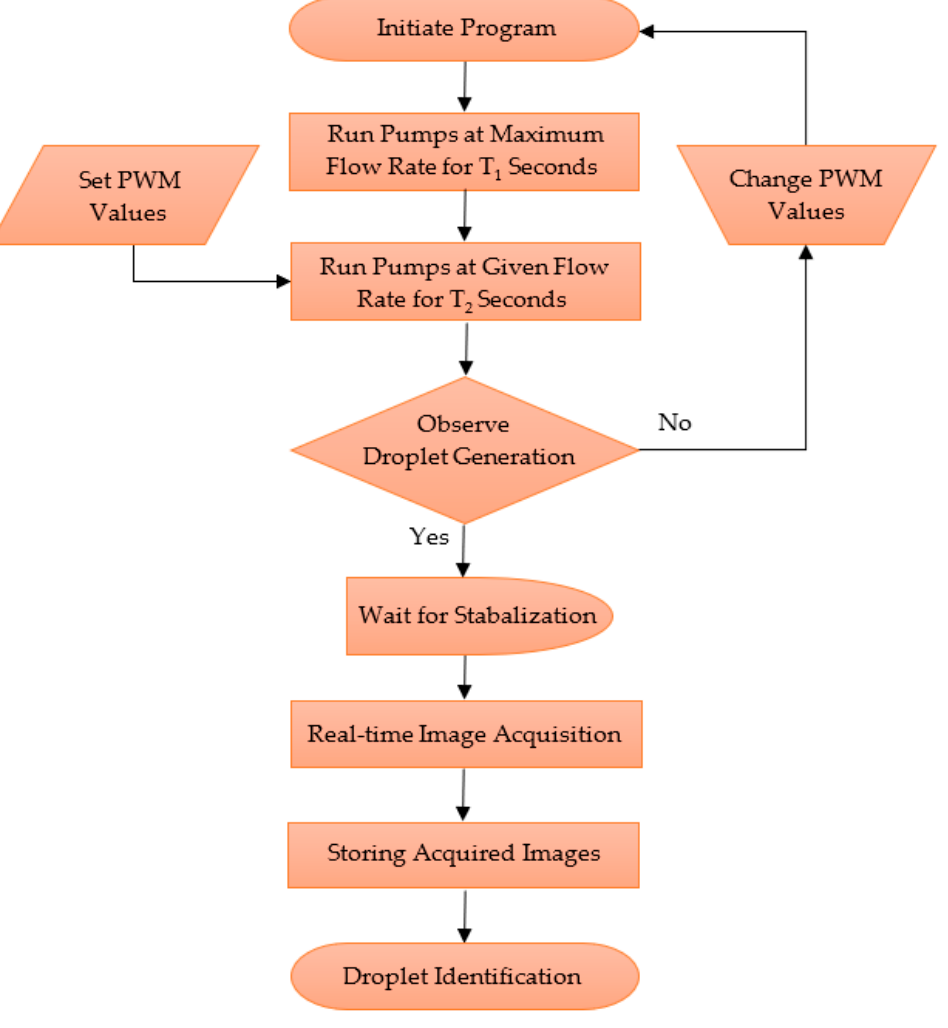
Figure 5. Control architecture of the system.